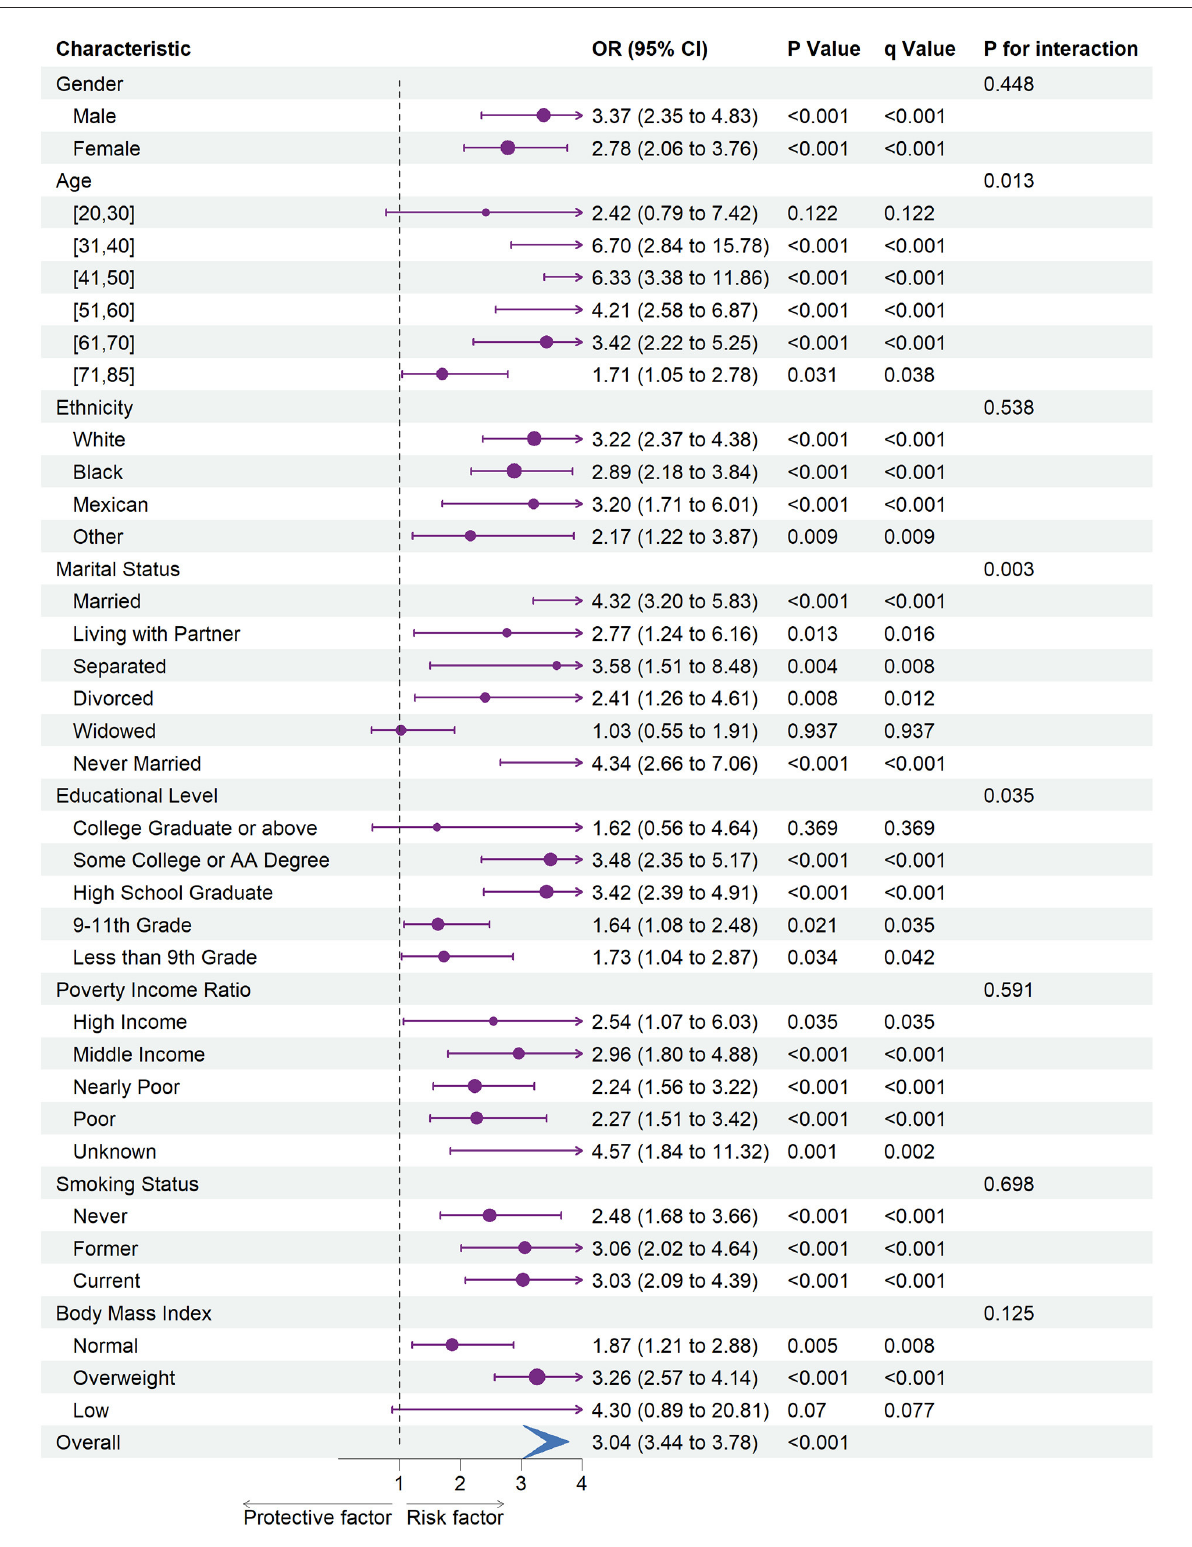
FIGURE2 The association between depression and stroke risk in each subgroups. OR, odds ratio; CI, confidence